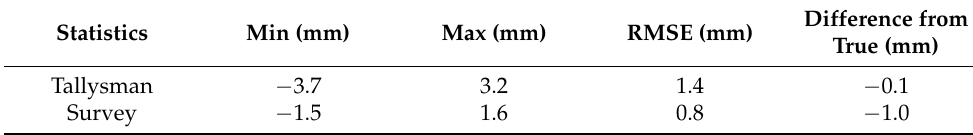
Table 4. Horizontal distance statistics for the low-cost uncalibrated antennas.